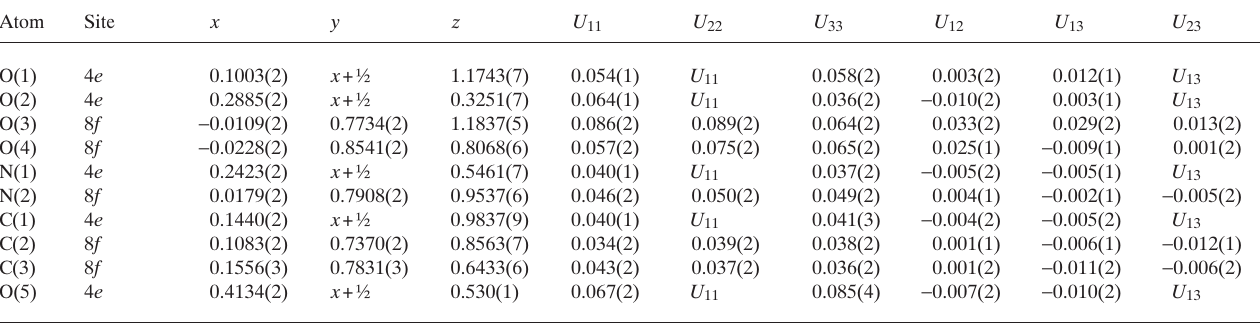
Table 3. Atomic coordinates and displacement parameters (in Å 2 ) .